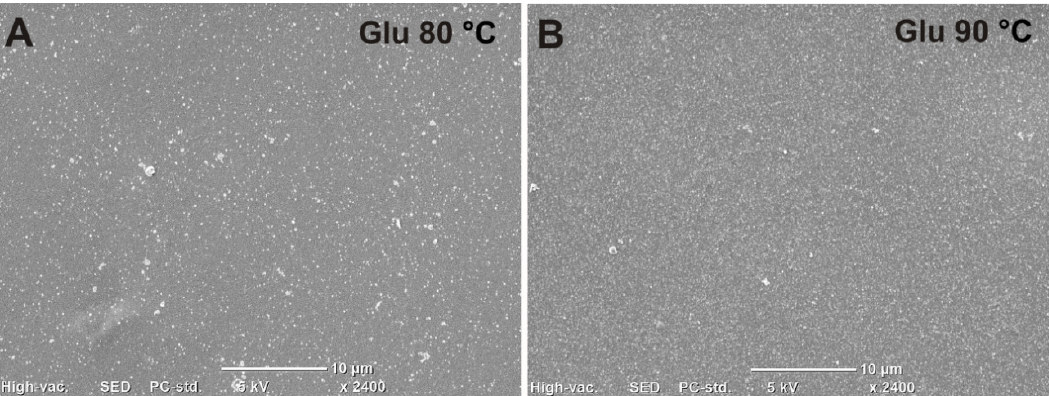
Figure 9. SEM (scanning electron microscopy) micrographs presenting surface morphology of glucan matrix gelled at 80 °C ( A ) and 90 °C ( B ).